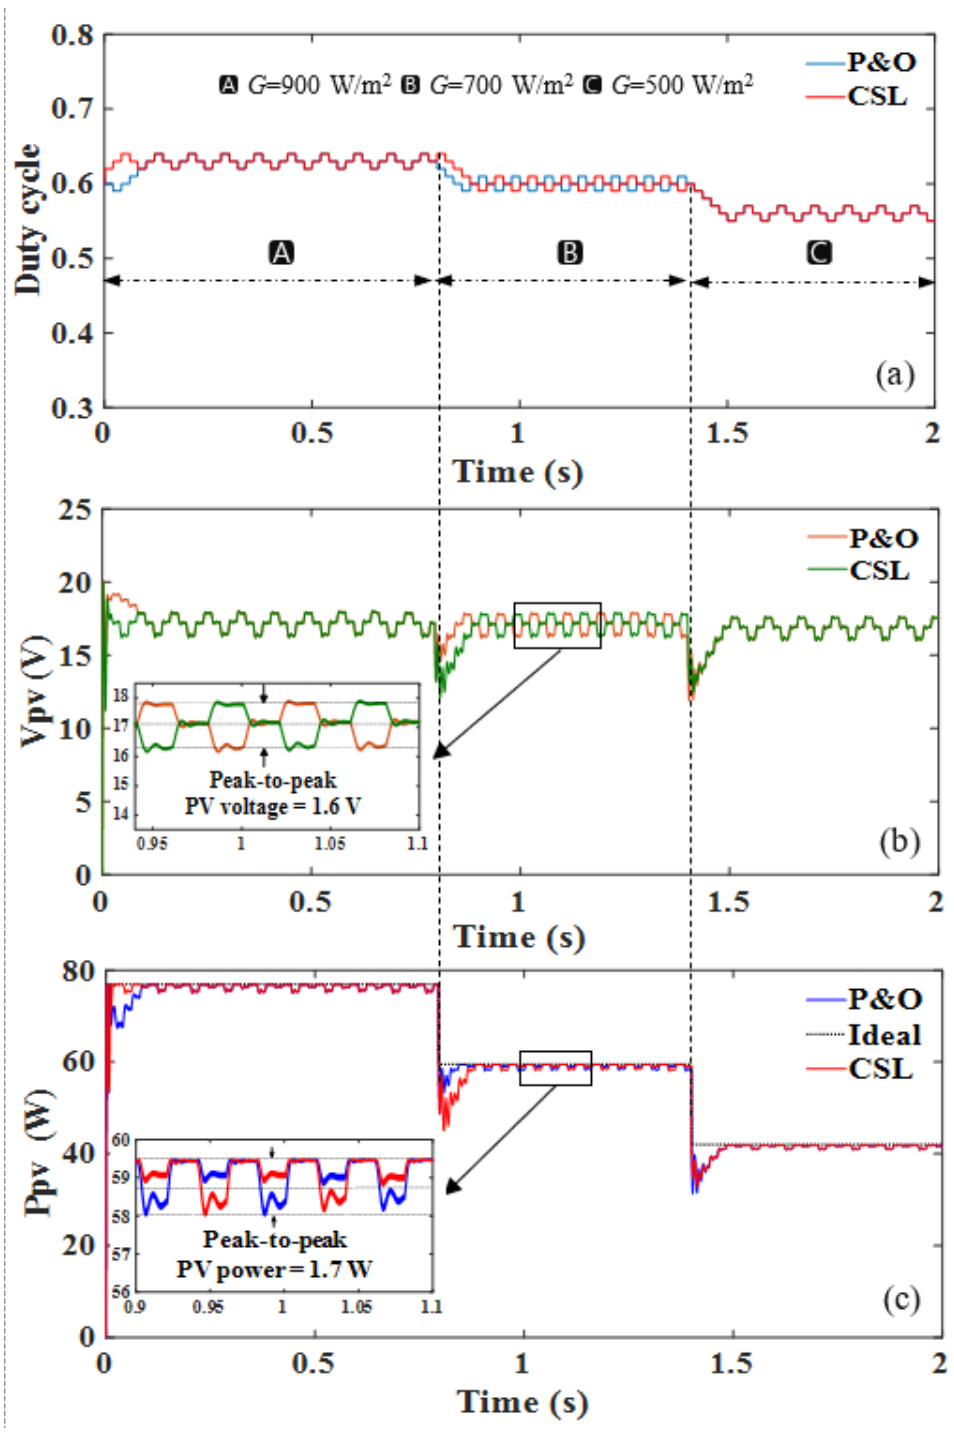
Figure 10. The simulation result of the tracking waveforms for both P&O-MPPT and CSL-MPPT algorithms: ( a ) duty cycle, ( b ) PV module voltage, and ( c ) PV module power.